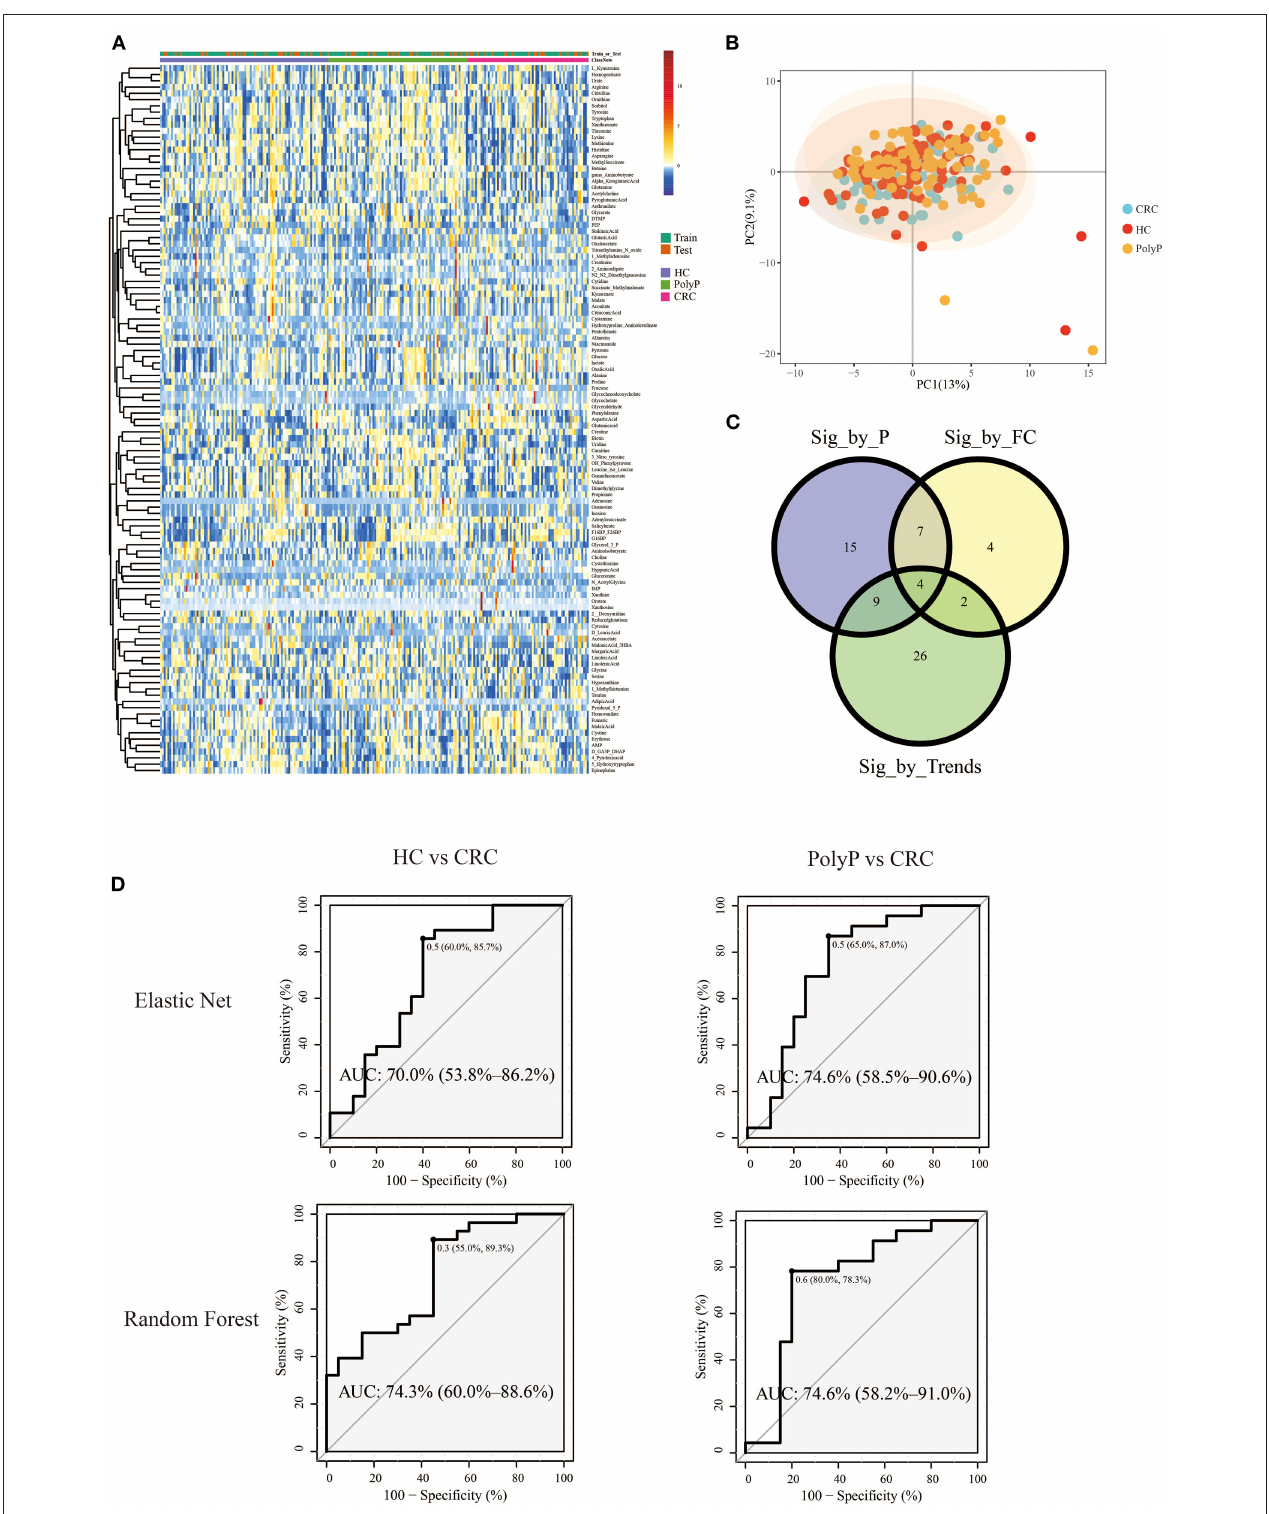
FIGURE 4 | Metabolomic profile and predictive models built by selected metabolites. (A) Heatmap showed the Z-score value of metabolites intensity. The annotation bars above the heatmap showed groups and train/test information of the samples. (B) PCA scores plot. (C) Venn plot showed the intersections of metabolites filtered by three different criteria. (D) ROC plot of random forest and elastic net. The optimal cutoff value, specificity, and sensitivity were shown beside the optimal cutoff point in the ROC plot. The AUC and 95% Confidence interval was shown in the middle of the ROC plot.